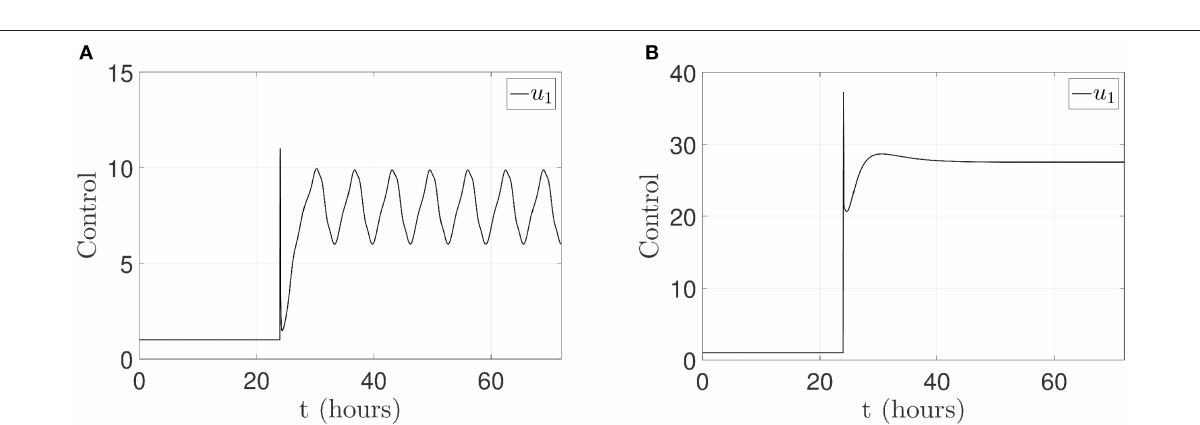
Frontiers in Physiology |